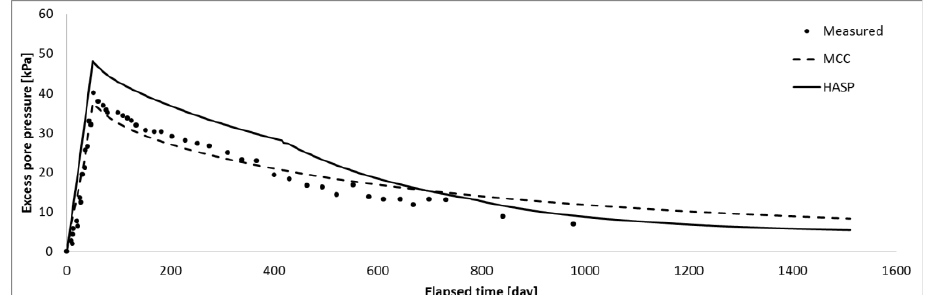
Figure 12. Comparison of excess pore pressure-time curves for Embankment A—Point P 2 (5.0 m below the surface).